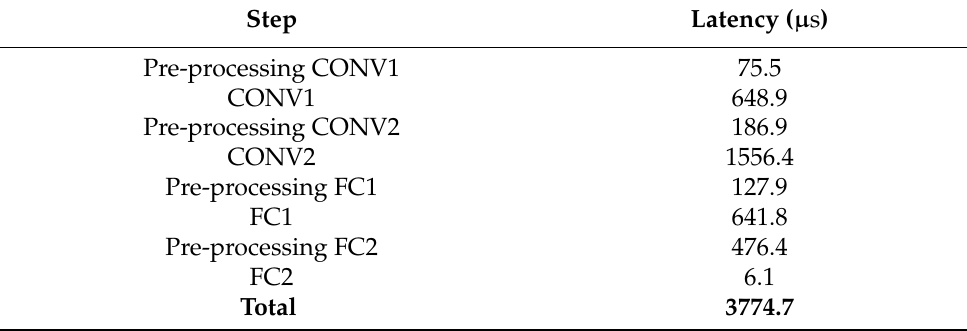
Table 2. A breakdown of the latency for step of the code. A clock frequency of 100 MHz is